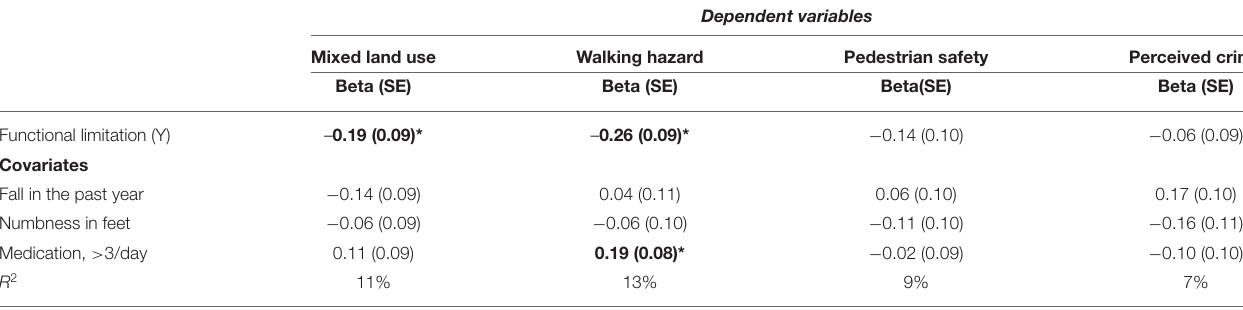
TABLE 3 | Multivariate regression analysis to predict NEWS subscales after controlling for